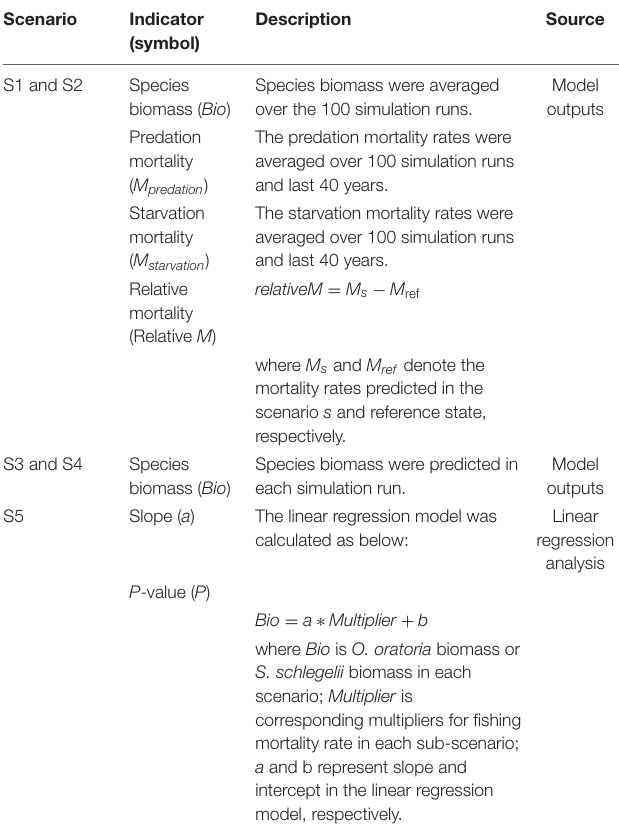
TABLE 2 | Definitions of indicators in scenarios S1 to